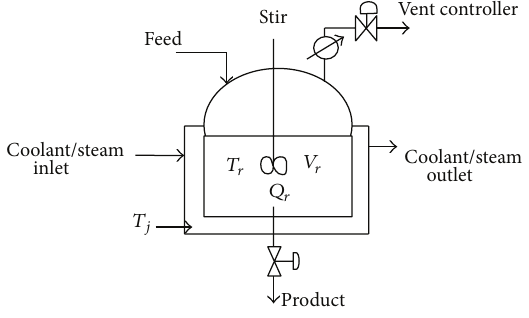
Figure 1: Schematic diagram of a jacketed batch